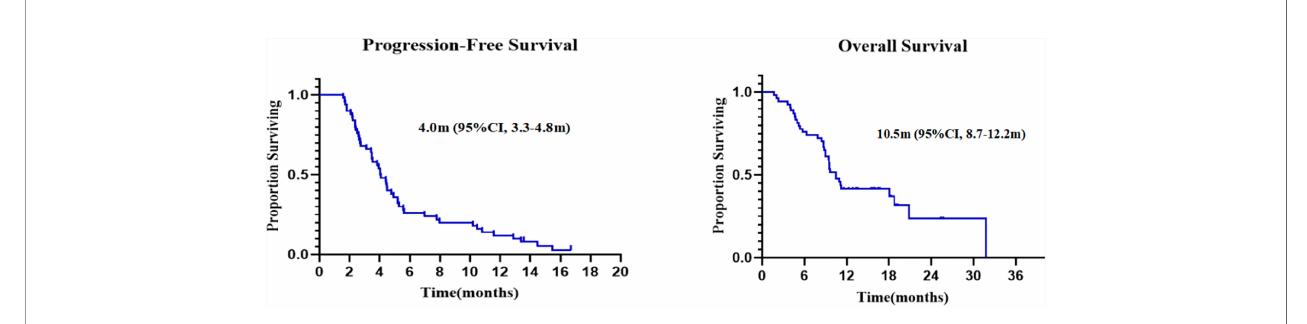
FIGURE 4 | Kaplan – Meier curves of progression-free survival and overall survival.